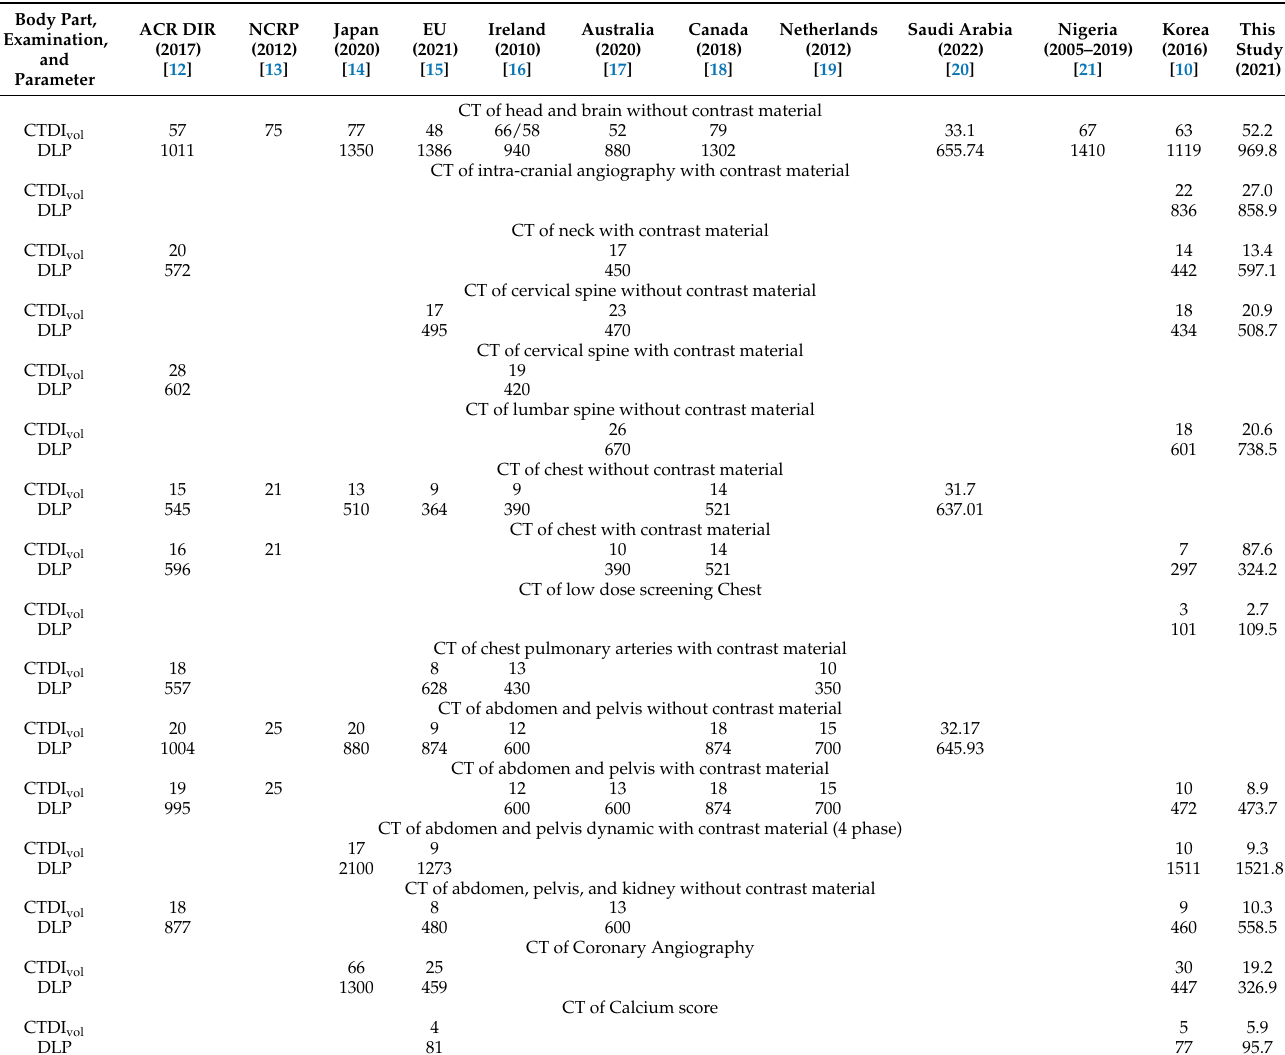
Table 6. Comparison of 75th % DRLs between other countries and the current survey of adult CT